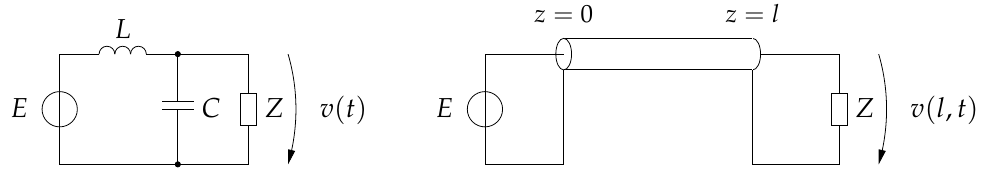
Figure 4. Setup for the transient simulation of both converters with d ≡ 1: passive network of the classical buck converter ( left ), transmission line of the distributed buck converter ( right